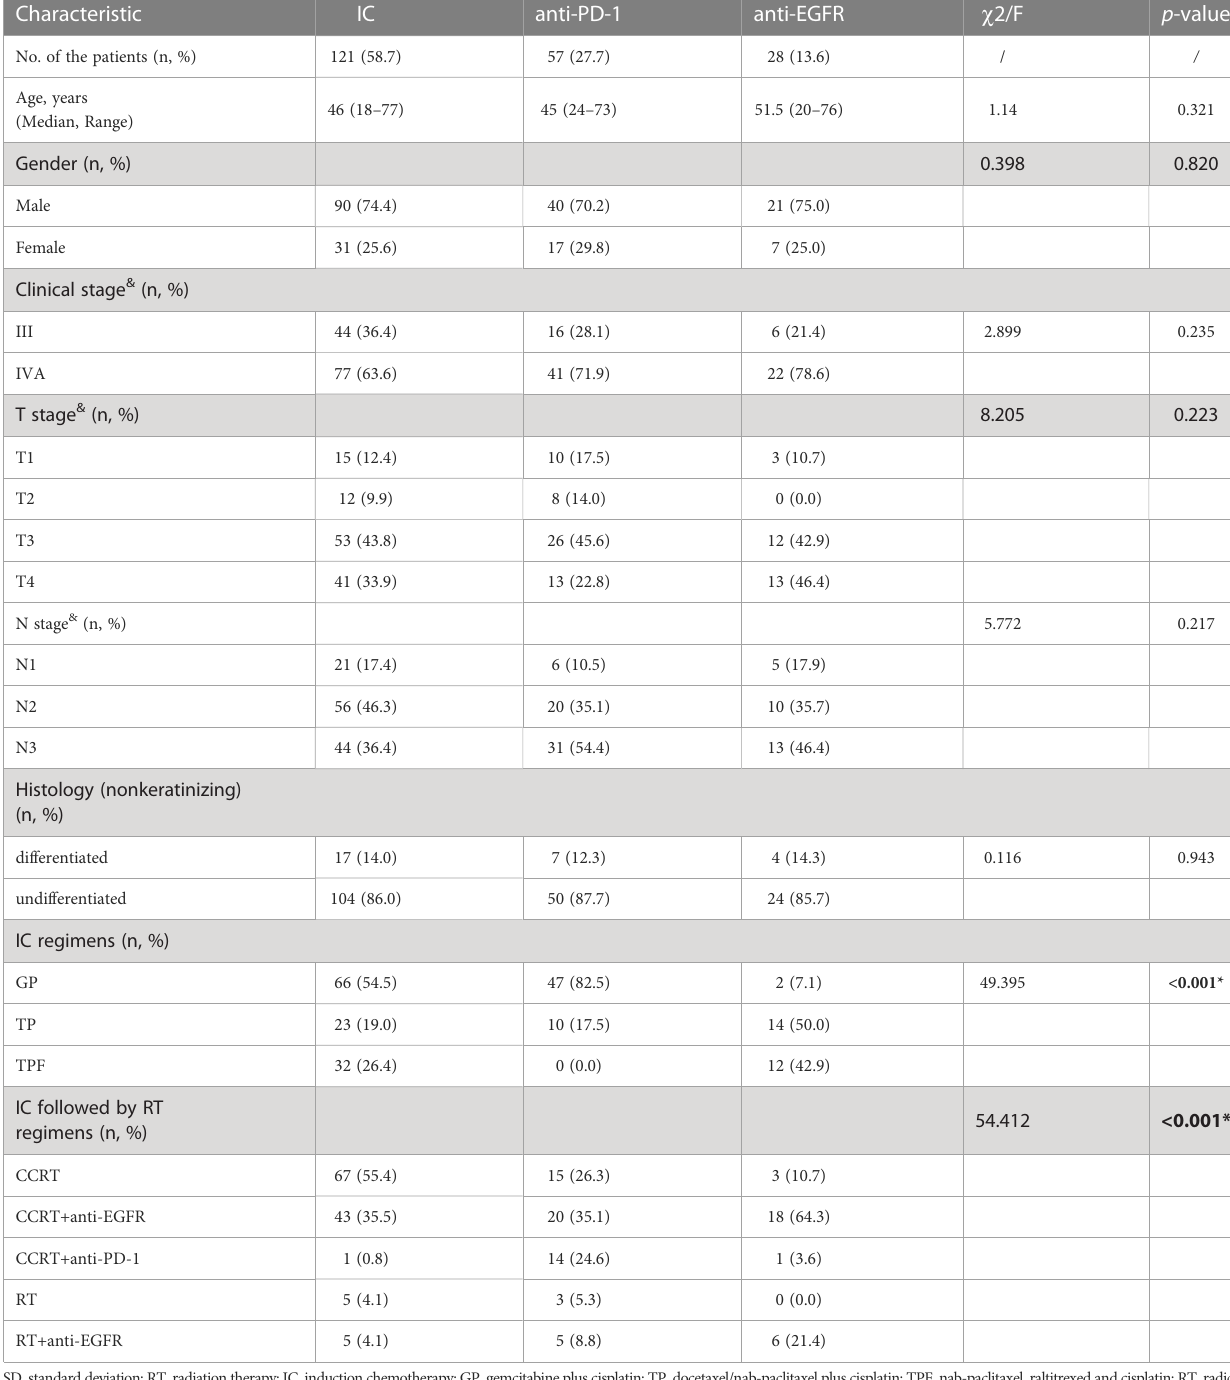
TABLE 1 Basic clinical characteristics of the patients and the speci fi c regimens.